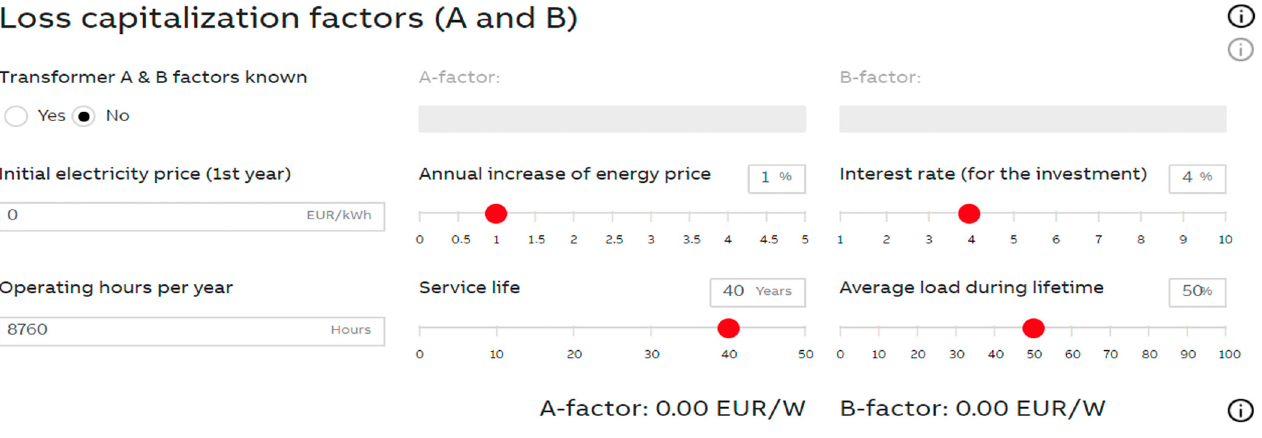
Figure 2. ABB loss capitalisation